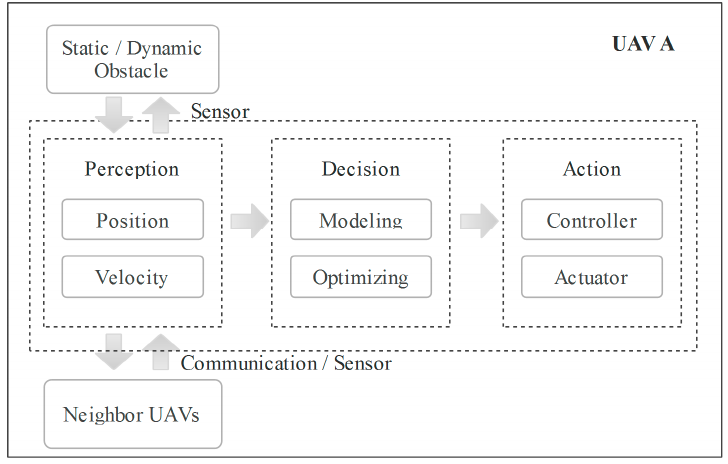
Figure 1. A concise overview of the continuous procedure of each UAV.